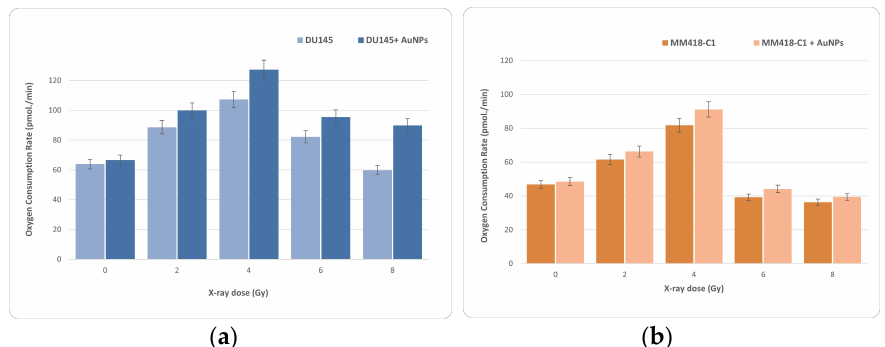
Figure 7. Oxygen consumption rate from a mitochondrial stress test of irradiated DU145 ( a ) and MM418-C1 ( b ) cell lines. Data represent mean values from 20 wells ± SD of three replicate samples.